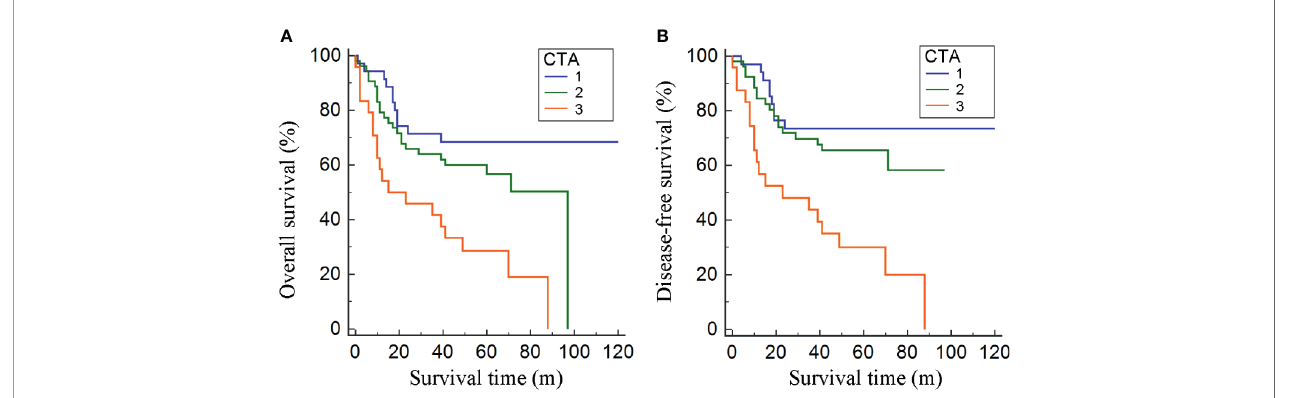
FIGURE 3 | Kaplan – Meier curves for OS and DFS divided by the combination of total psoas index and albumin – globulin score (CTA) grade (A, B)